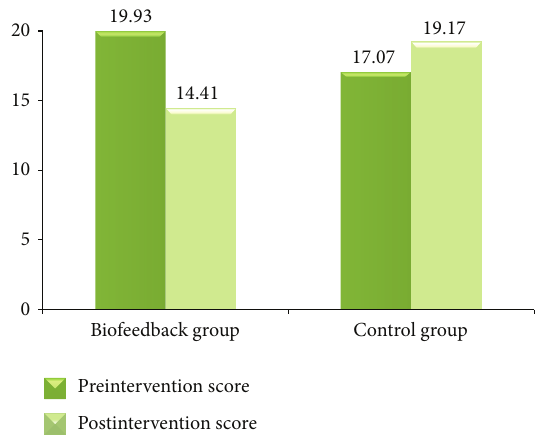
Figure 2: Pre- and postintervention mean scores for State Anxiety Scale.